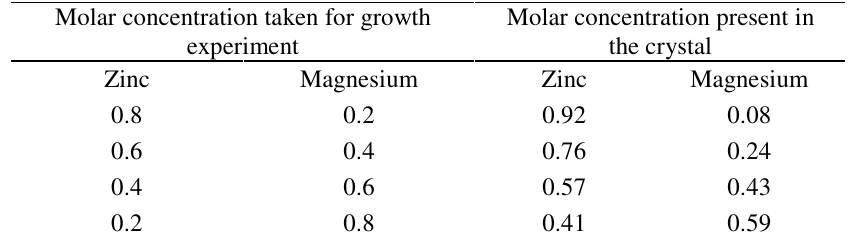
Table 1. Molar concentration of zinc and magnesium in the growth solution and the grown crystals Molar concentration taken for